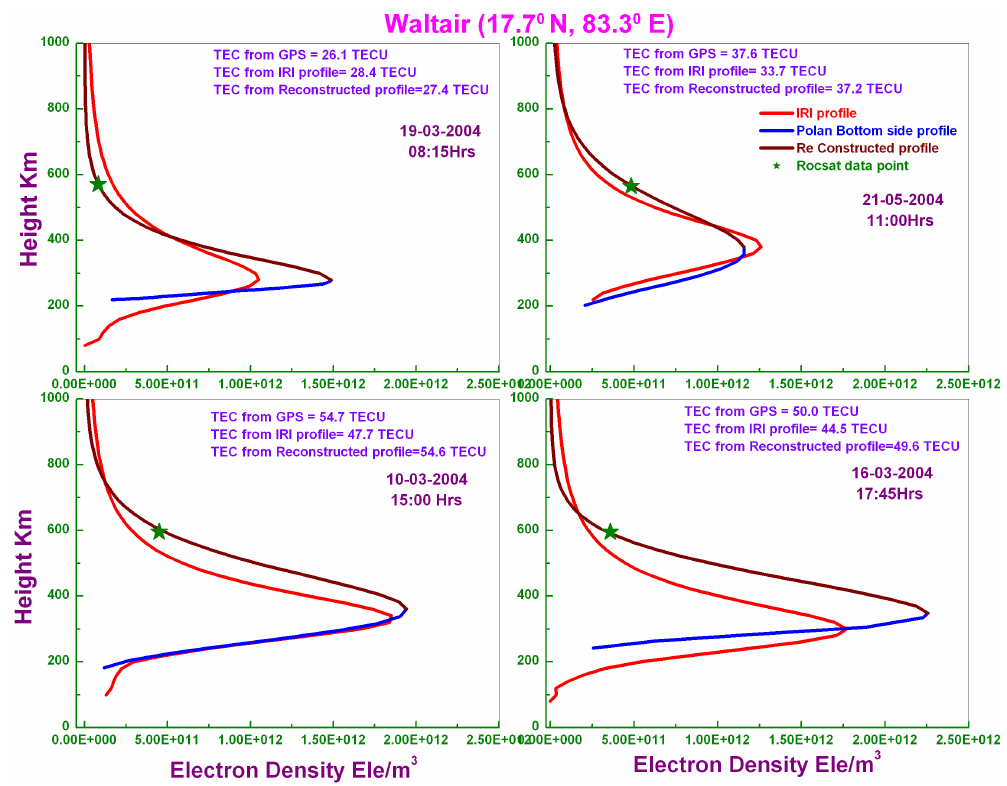
Fig. 3. Typical examples of vertical electron density profiles reconstructed over a low latitude station Waltair during four different time intervals. IRI model derived profiles (red lines) are also plotted for